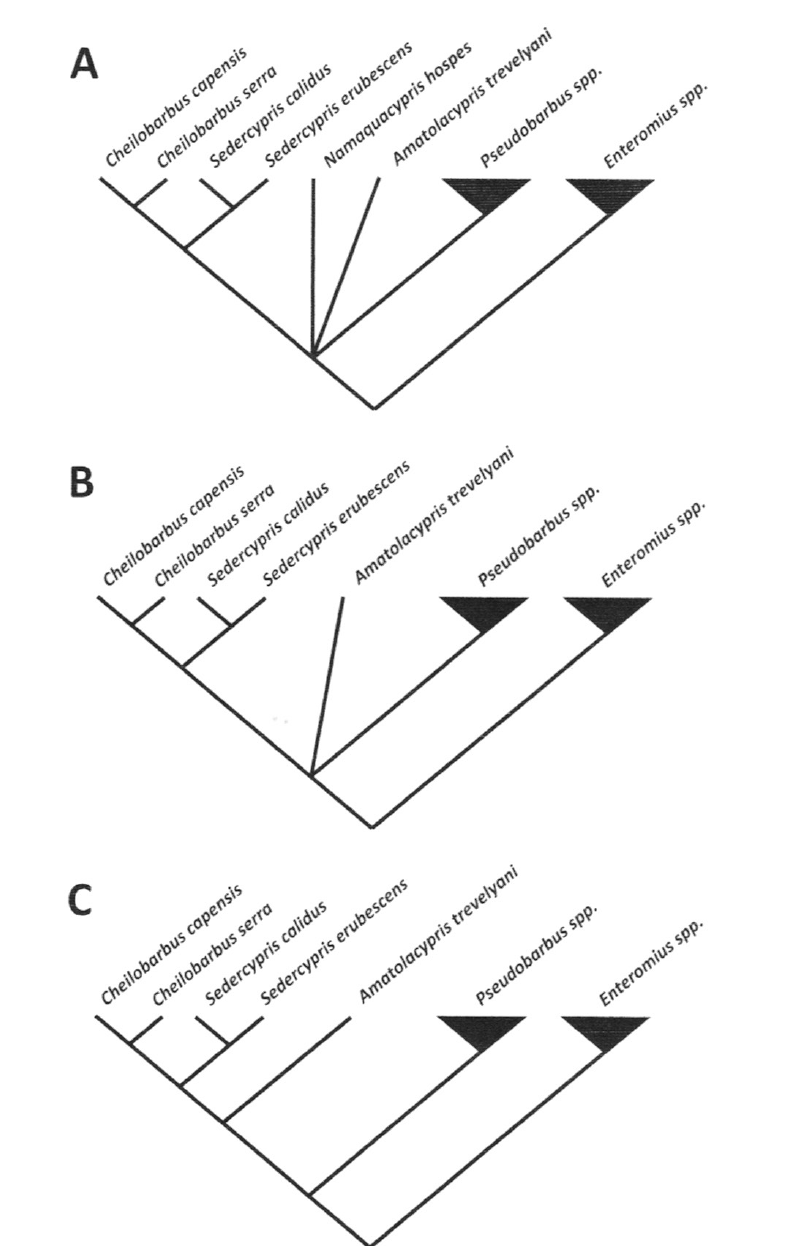
Fig. 8. Summary trees showing alternative phylogenies from the literature of the tetraploid cyprinines from southern Africa, using the nomenclature proposed by the present study. Only relationships with bootstrap support >80 or Bayesian posterior probability support greater than 95% were considered and all unsupported relationships were collapsed. A . The present study. B . Tsigenopoulos et al. (2002); de Graaf et al. (2007); neighbour-joining tree, De Graaf et al. (2010); Berrebi et al. (2014); Yang et al. (2015). C . Bayesian tree by de Graaf et al.